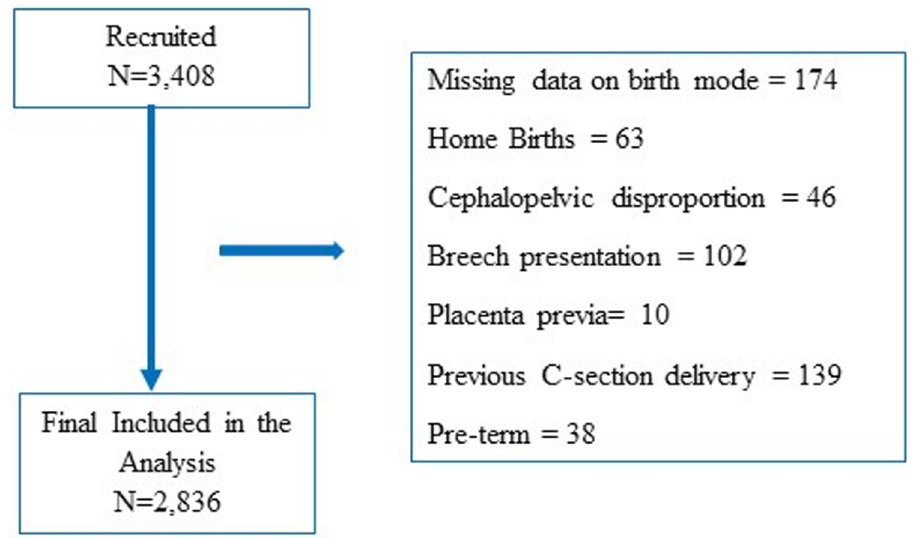
Fig 1. Flow diagram of the selection of study cohort included in the prediction